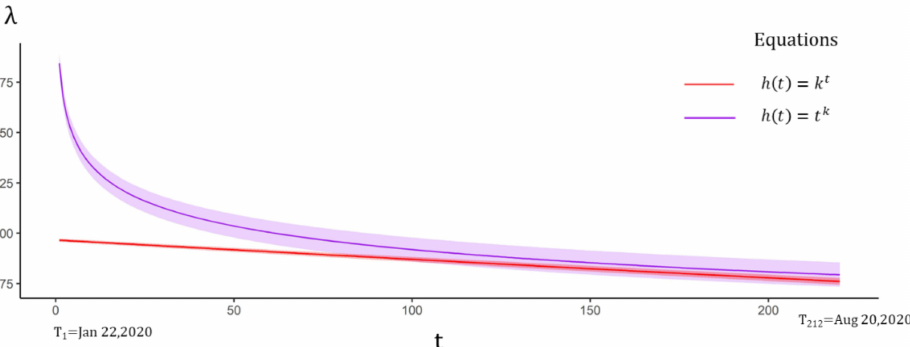
Figure 5. Time-varying RDR with 95% CI estimated by Equation (17). If the time effect of UIR was not considered, the fitting results showed that RDR exhibited a decreasing effect over time, which meant that IFR might be slowly increasing.